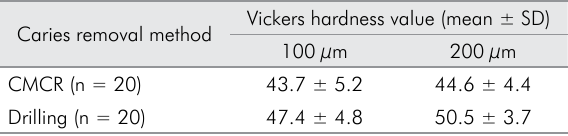
Table 2. Microhardness of residual dentin after caries removal according to comparison